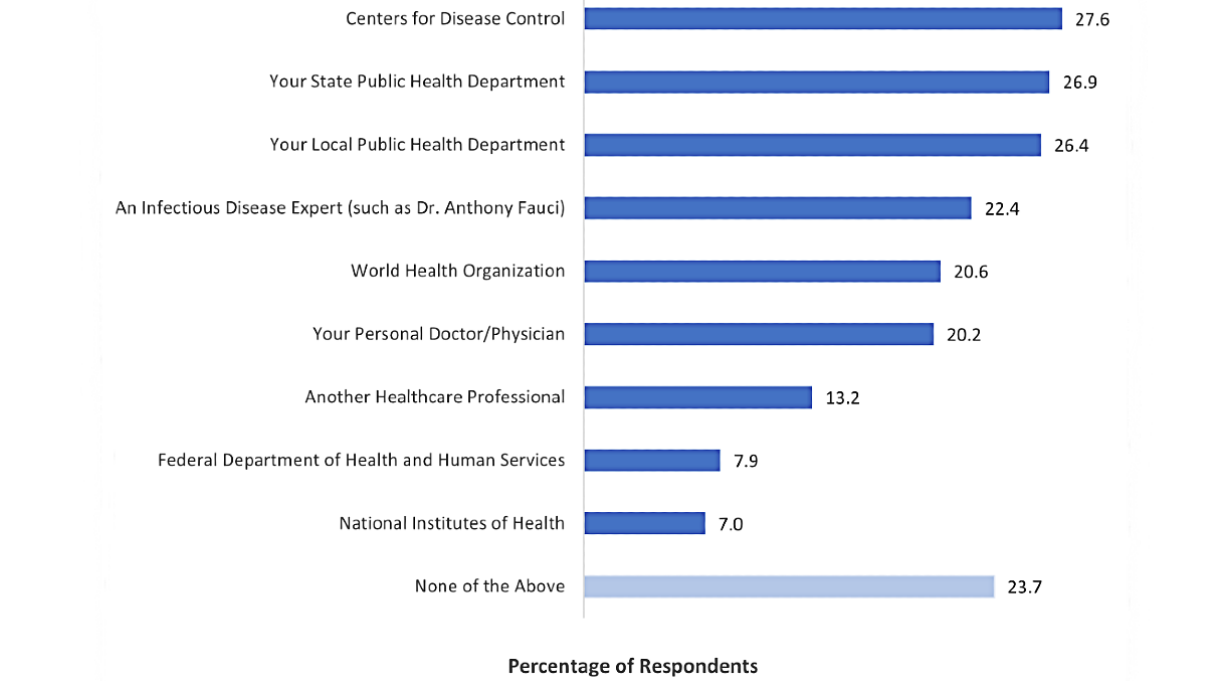
Figure 1. Health Information Sources "Followed" (As % of